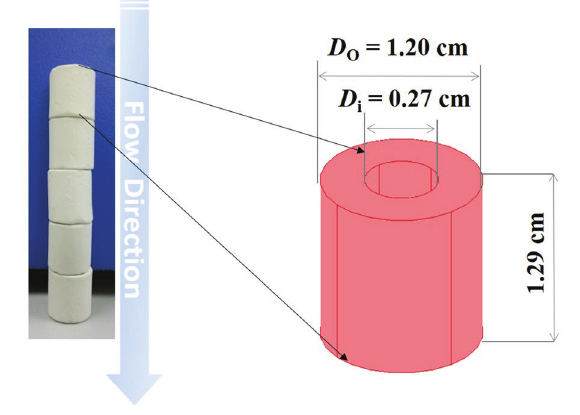
Fig. S2 – Dimensions of Raschig